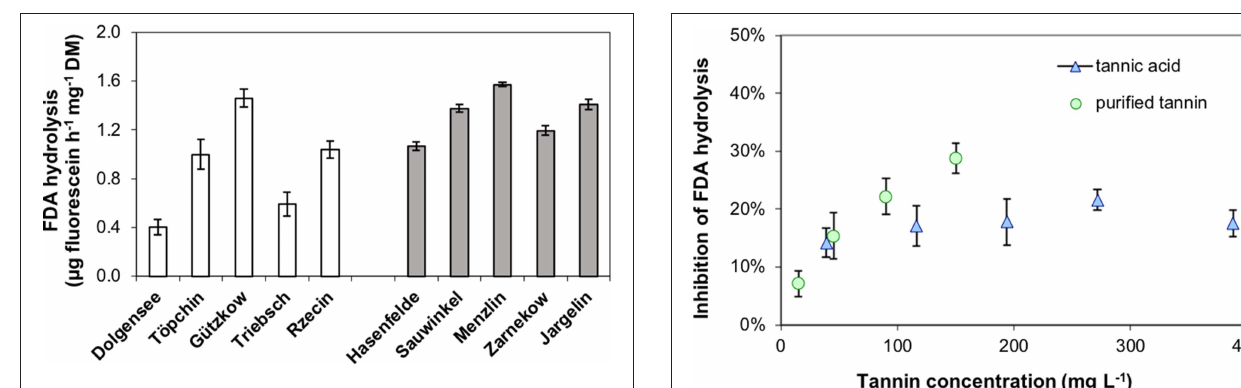
FIGURE 5 | Microbial activity of studied peat soils measured as hydrolysis rate of fluorescein diacetate (FDA) for pristine peatlands with less decomposed peat (white bars) and rewetted peatlands with highly decomposed peat (gray bars).